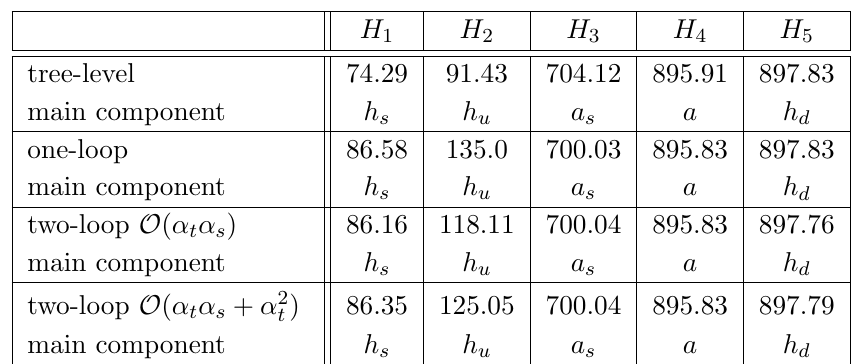
Table 2 . P1OS: mass values in GeV and main components of the neutral Higgs bosons at tree-level, one-loop, two-loop O ( (cid:11) t (cid:11) s ) and at two-loop O ( (cid:11) t (cid:11) s + (cid:11) 2 in the top/stop sector.